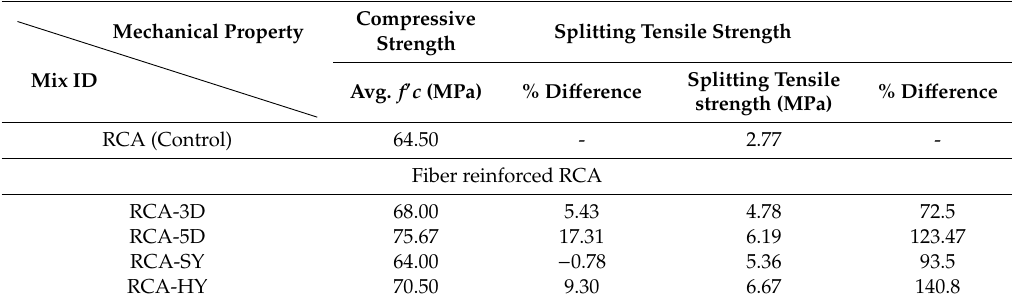
Table 7. Summary of the 90-day mechanical properties